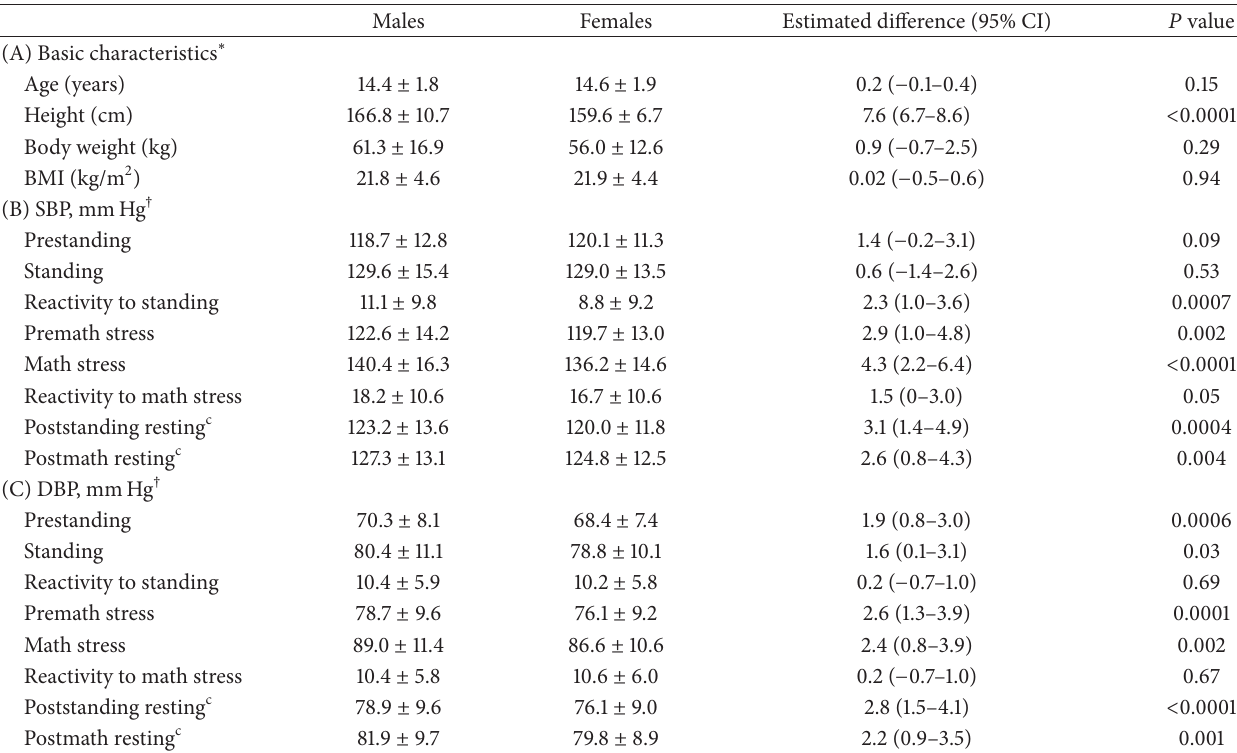
Table 1: Basic characteristics and studied BP phenotypes.